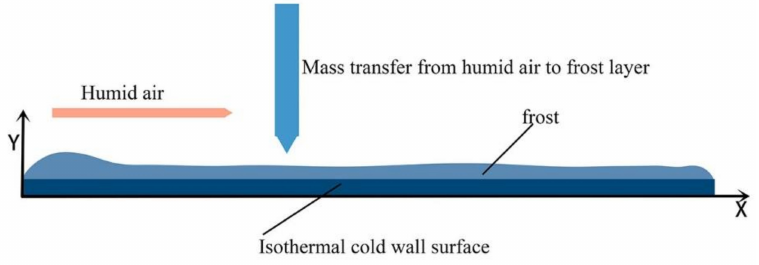
Figure 1. Frosting